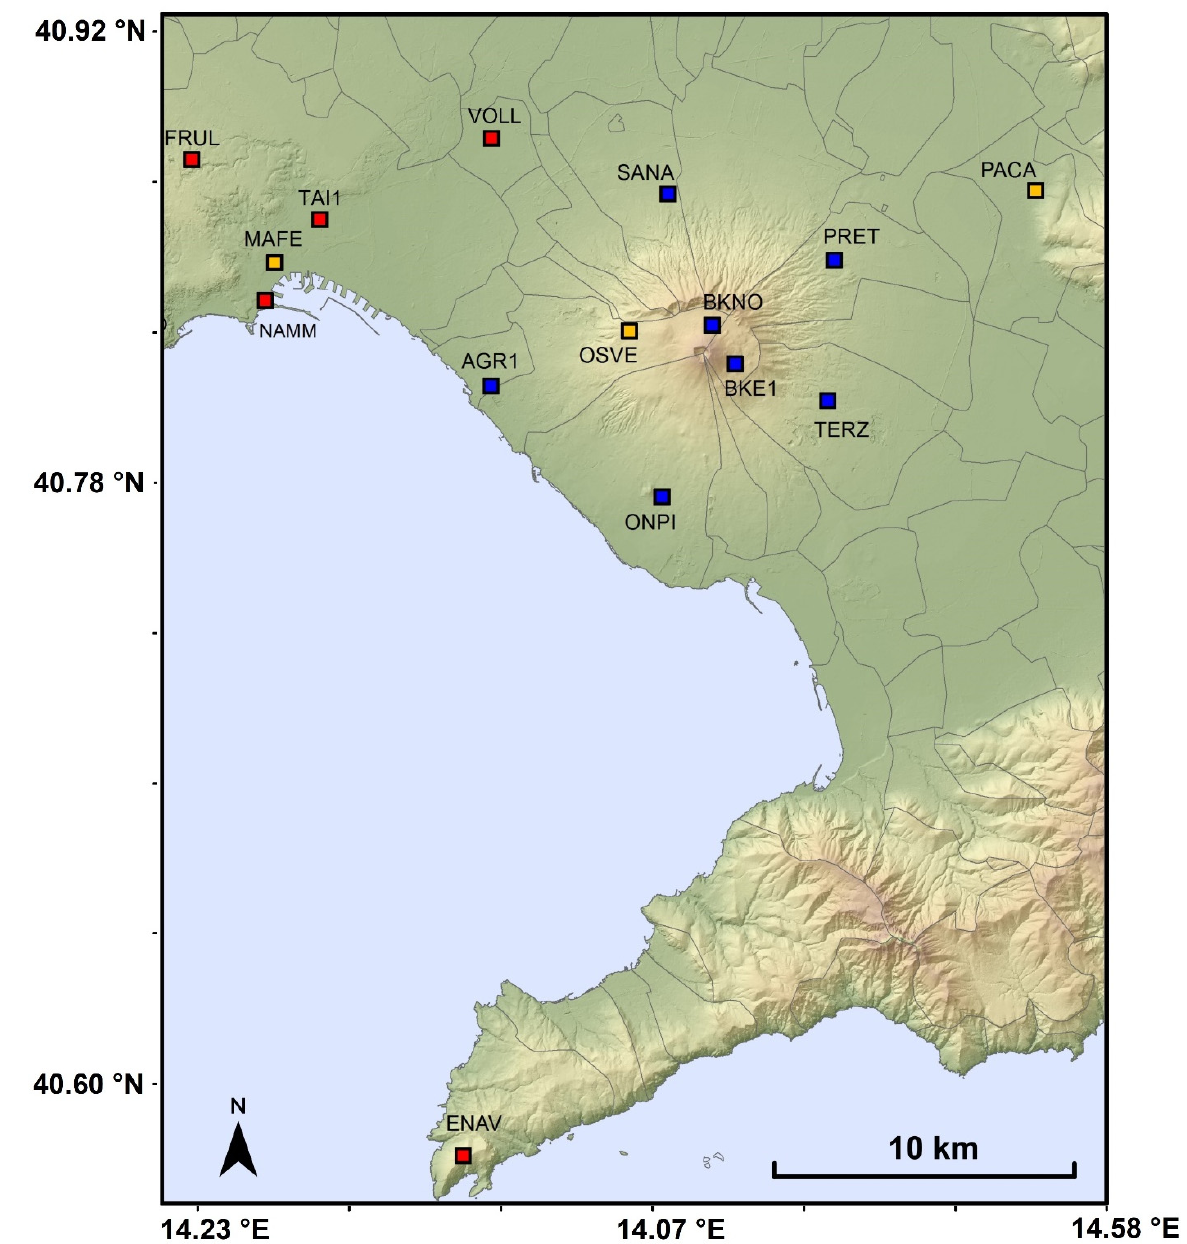
Figure 1. NeVoCGPS network. Selection of GPS sites used for the study of the thunderstorms (red and yellow squares) and the long-term PWV time series (blue and yellow squares). The map was produced by the INGV-OV Laboratory of Geomatics and Thermography. © LGT INGV OV.